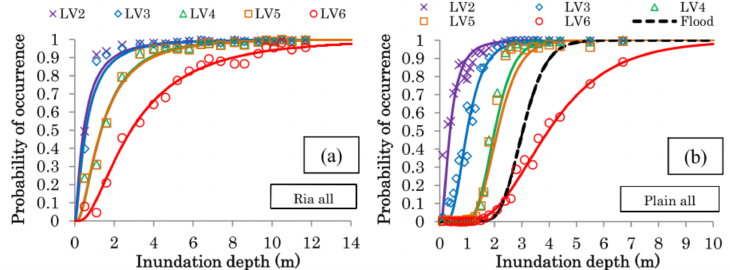
Figure 1. Fragility functions for ria (mountainous) coast ( a ) and coastal plains ( b ), but both from the same city of Ishinomaki, Japan [3]. This suggests that using only one Tsunami Intensity Measure (TIM), inundation depth, is insufficient to capture the damage potential of the flow.